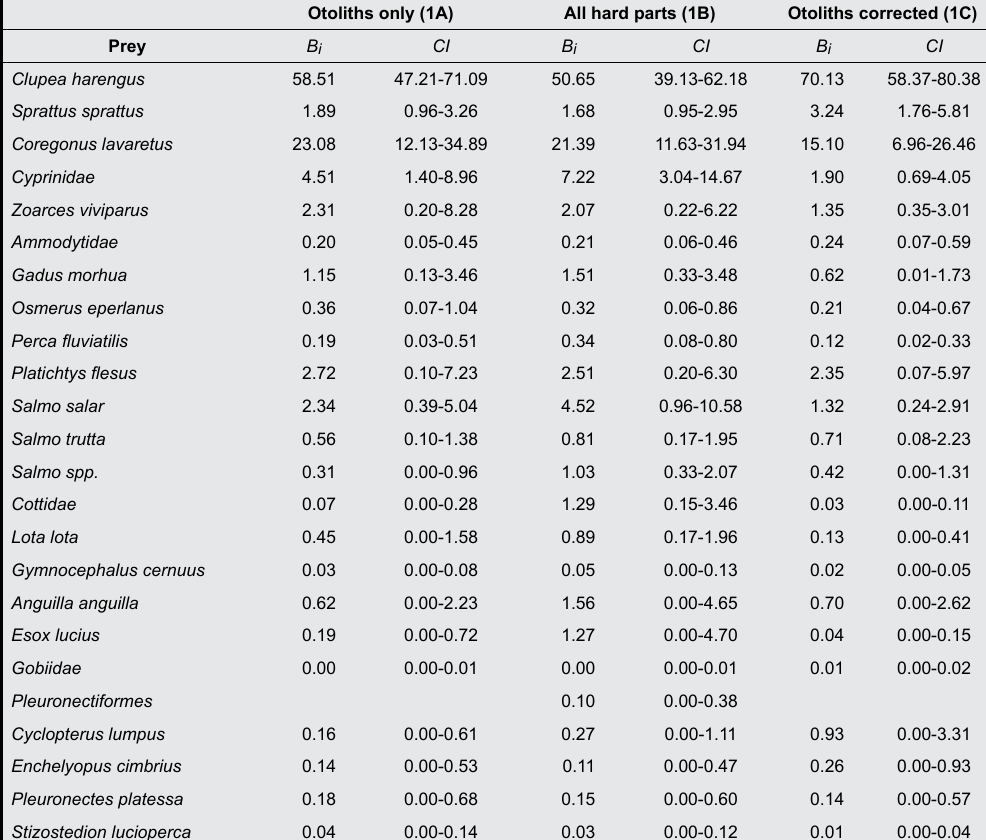
Table 8. Estimated relative contribution in percent to estimated biomass (Bi) of consumed prey individuals with upper and lower range of the 95% confidence interval (CI). Indices were calculat - ed using otoliths only (method A), all recovered hard-part structures (method B) and otoliths with numerical and size correction factors applied (method C), for all data pooled (model 1) in Table 8a and seal weighted average (model 2) in Table